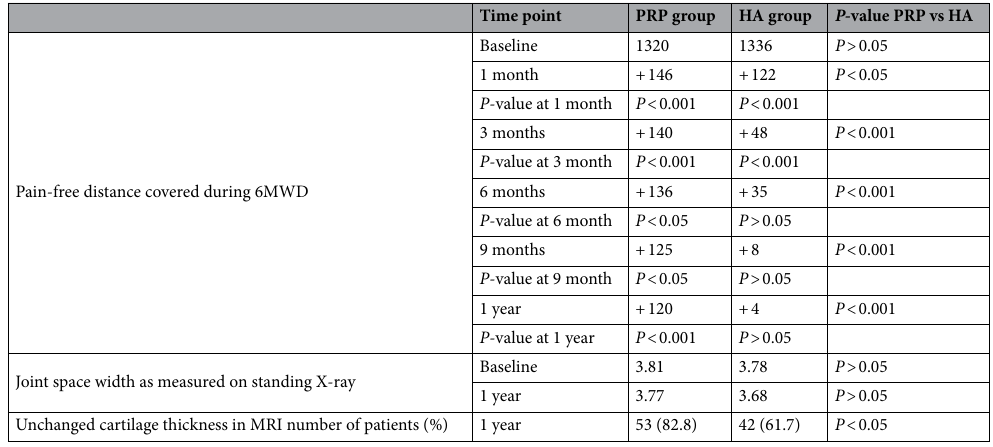
Table 4. Pain-free distance covered during 6MWD test and Joints width in PRP and HA groups over 1 Year. 6MWD 6-min walking distance, PRP Platelet-rich plasma, HA Hyaluronic acid, n number of